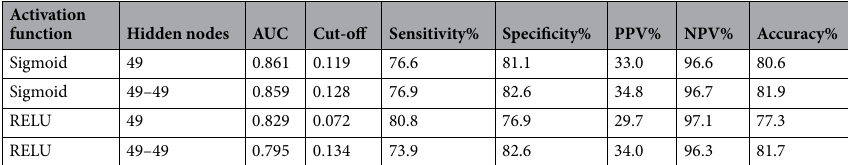
Table 2. Test results regarding the detection of pneumothorax location in chest X-rays using convolution neural networks with a sigmoid or RELU activation function for the fully-connected hidden nodes.